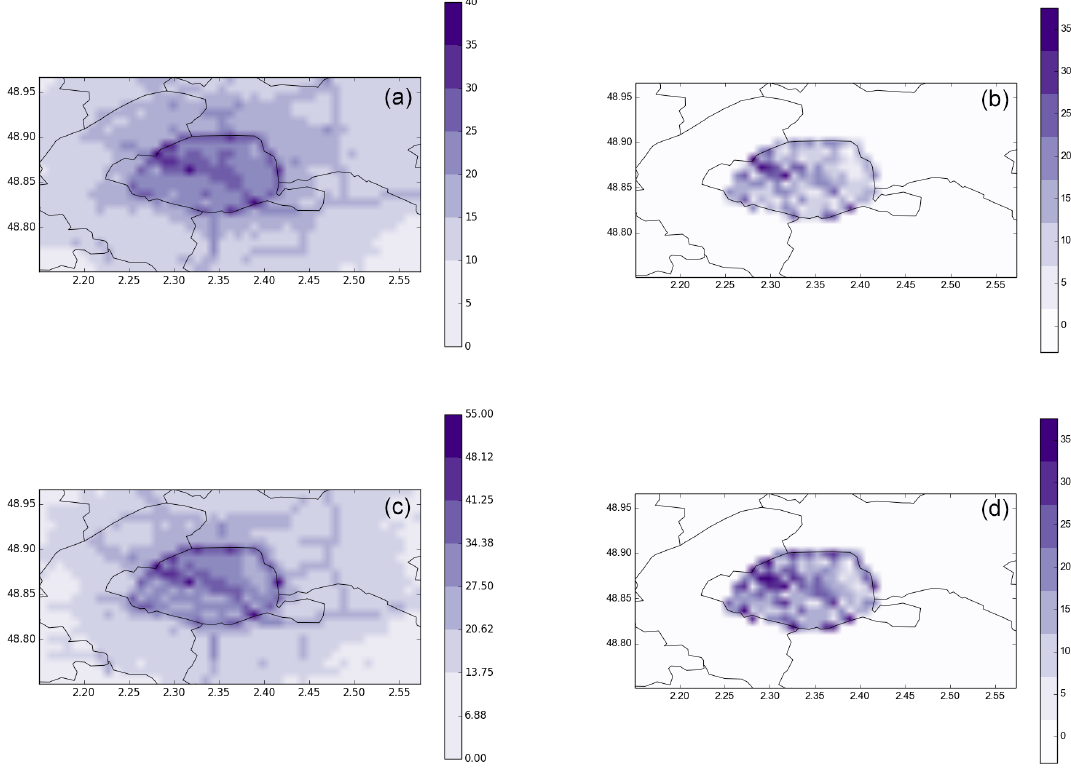
Figure B2. NO 2 (a, b) and NO x (c, d) concentrations simulated over Paris with SinG (a, c) and relative differences between SinG and Polair3D in percent (b, d)